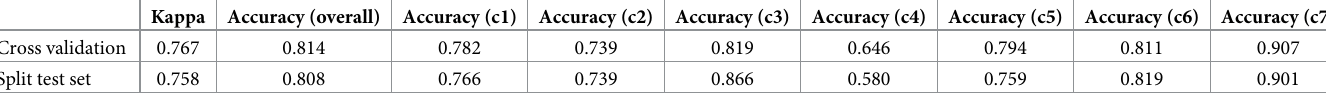
Table 1. Accuracy and kappa of the random forest